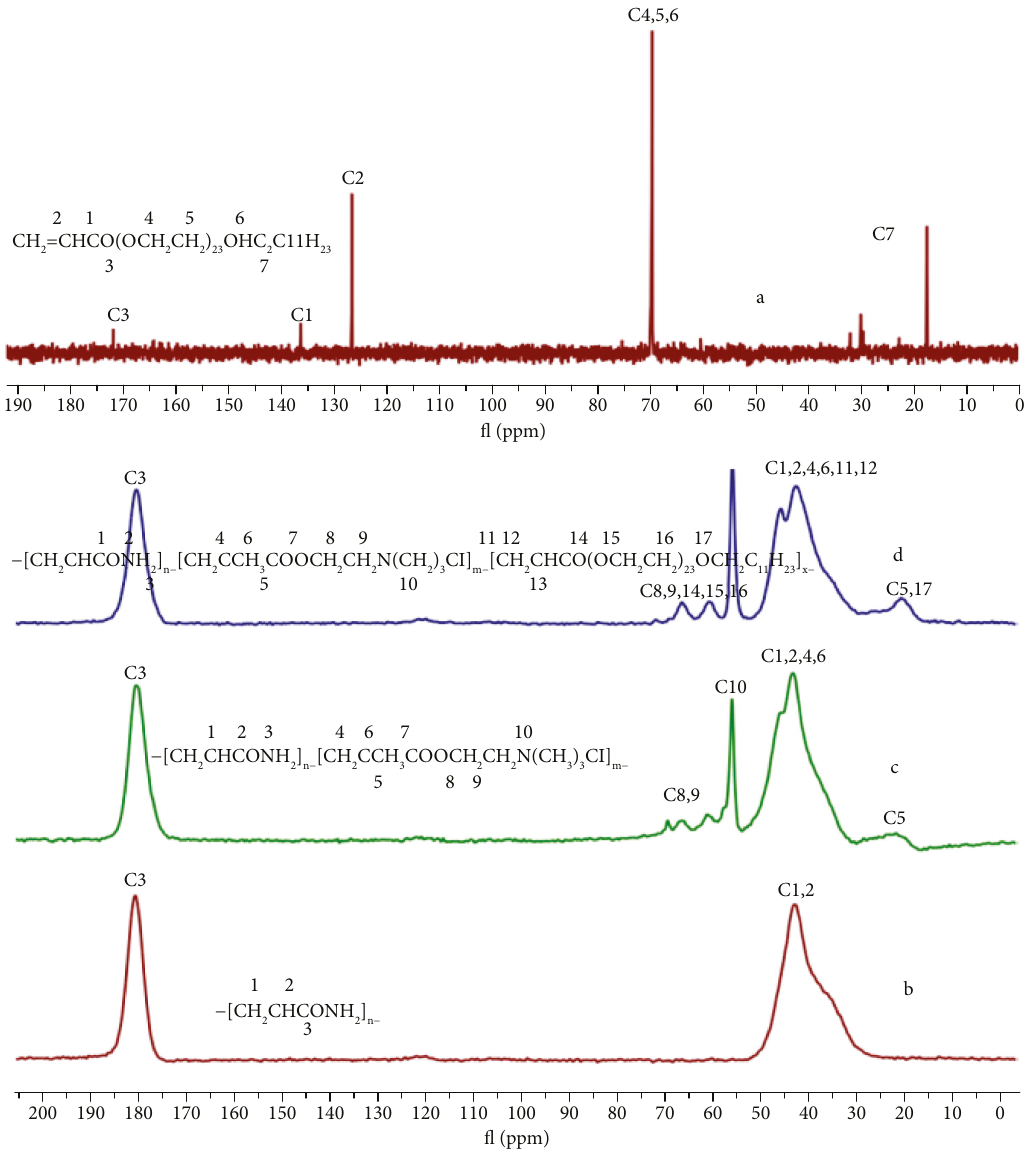
Figure 7: 13 C NMR spectra of DEA in D